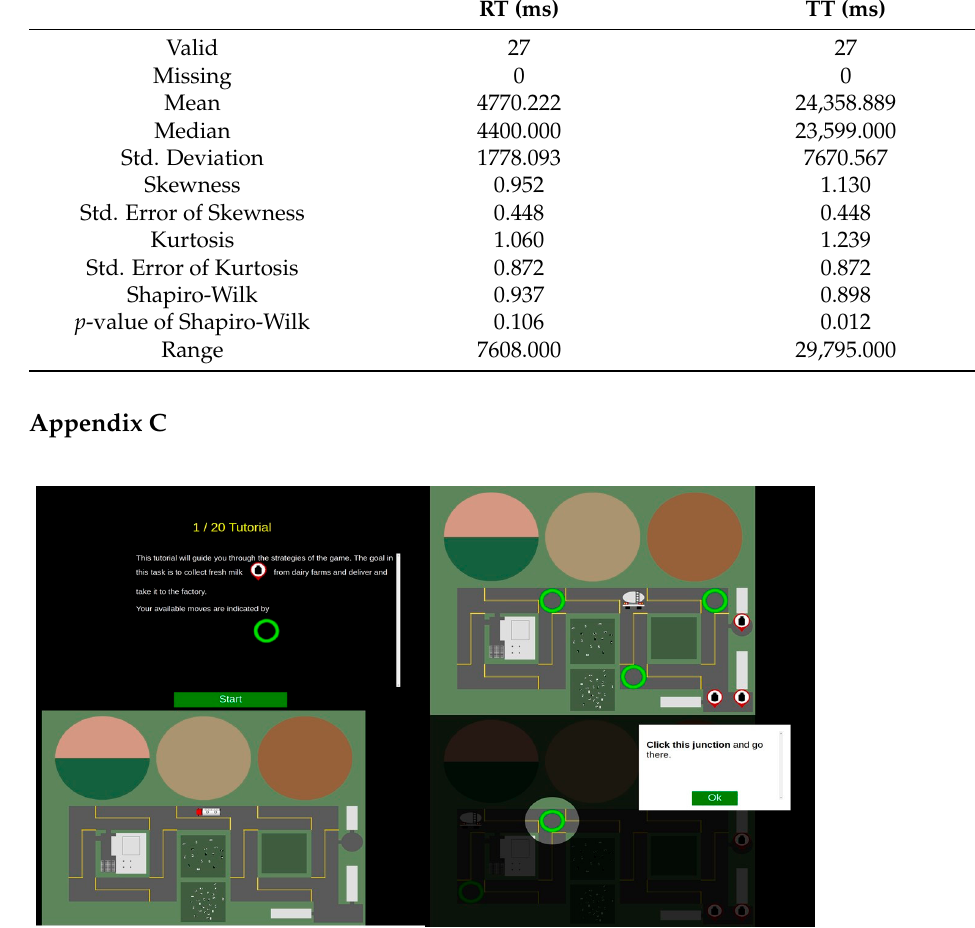
Figure A1. Screenshots of the tutorial with the instruction page.